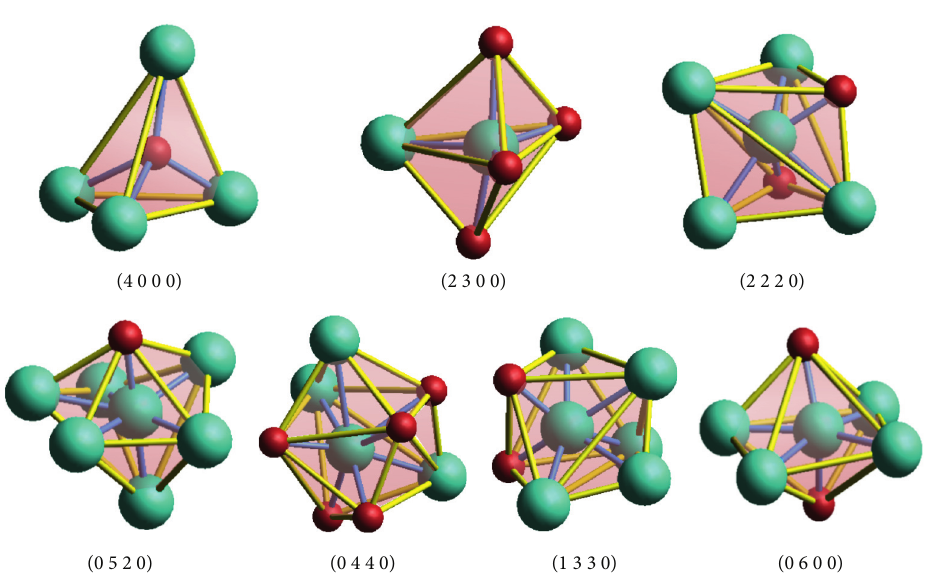
Figure 9: Basic clusters appearing during solidification of liquid SiC.